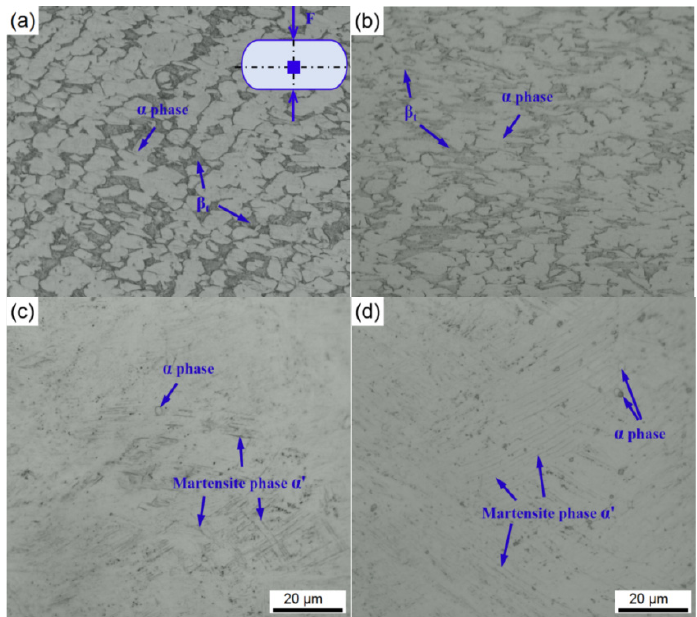
Figure 10. The microstructure of cross section for the compressed equiaxed microstructure specimens with a diameter of 1.5 mm at different current densities: ( a ) 0 A/mm 2 , ( b ) 30 A/mm 2 , ( c ) 50 A/mm 2 , ( d ) 70 A/mm 2 .